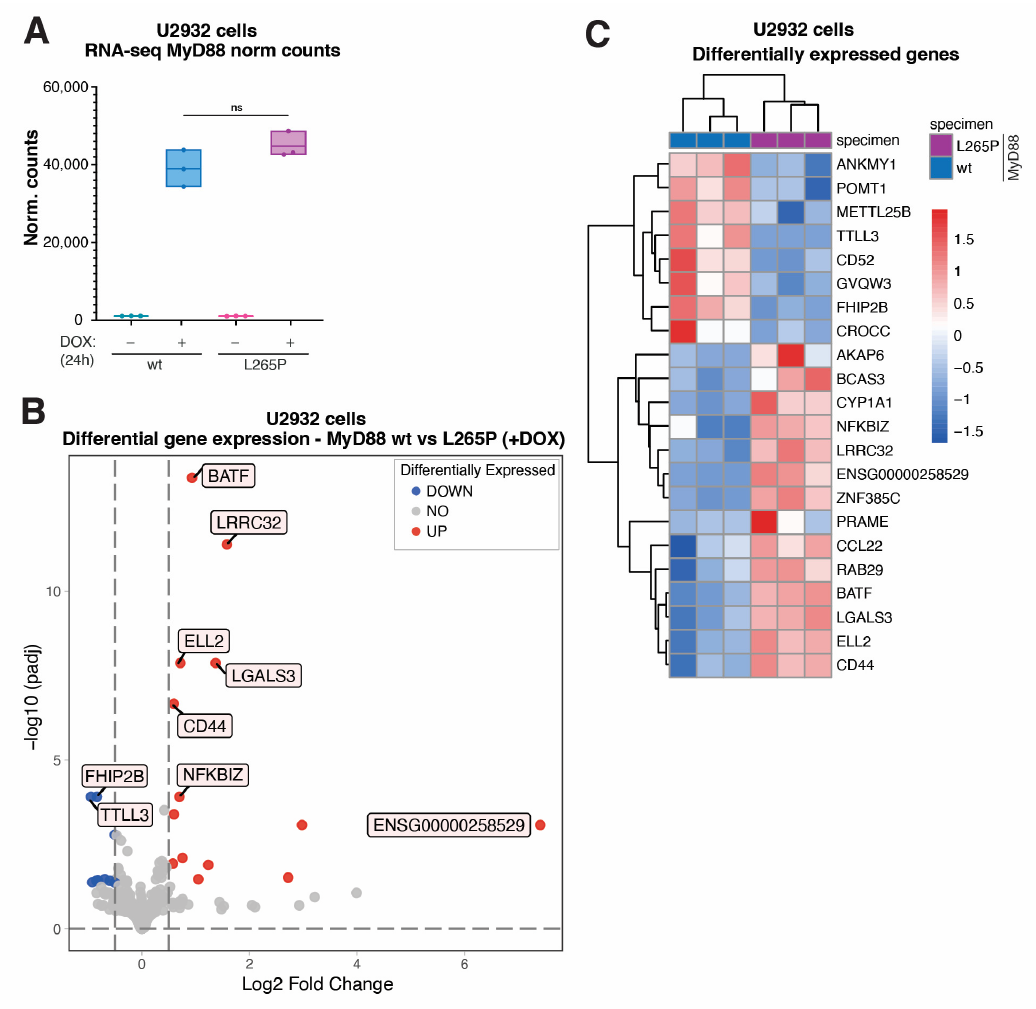
Figure 2. Transcriptome analysis (RNA-seq) of genes differentially expressed in U2932 lymphoma cells acutely expressing MyD88 L265P . ( A ) MyD88 normalized counts resulted from transcriptome analysis (ns for p > 0.05). ( B ) Volcano plot showing differentially expressed genes in U2932 cell lines inducibly expressing MyD88 vs. MyD88 L265P . The blue dots indicate downregulated genes, and the red dots indicate upregulated genes with Benjamini and Hochberg corrected p ‐ value less than 0.05 and an absolute value of log2 fold change greater than 0.5. ( C ) Heatmap representation of all the significantly differentially expressed genes (as described in ( B )) in U2932 cell lines expressing MyD88 wt vs. L265P.